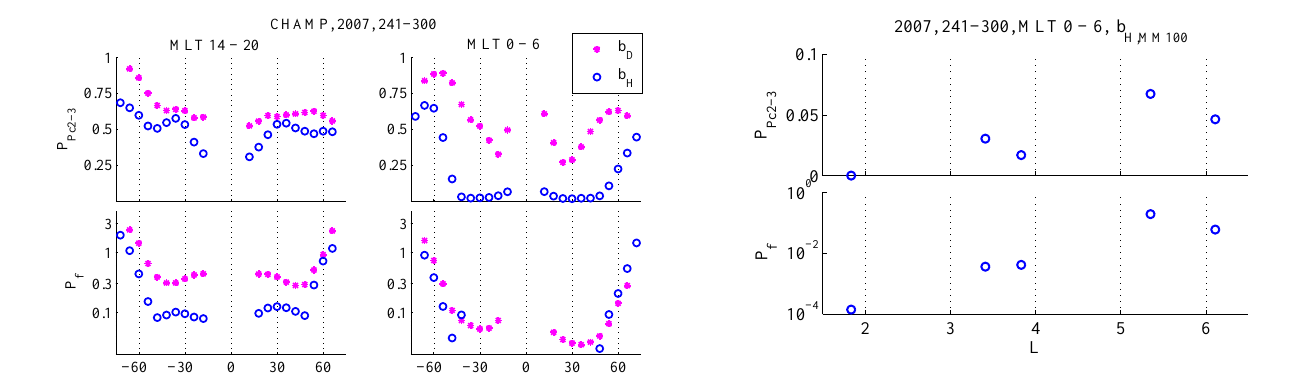
Figure 9. L distribution of the occurrence rate (upper panel)and PSD (bottom panel) along MM100 in the 00:00–06:00MLT sector over 2 months in 2007 for the meridional ( b H )